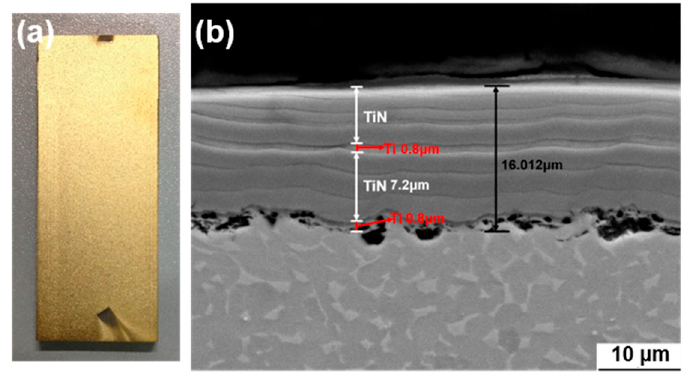
Figure 2. The microtopography of the surface ( a ) and cross-section ( b ).